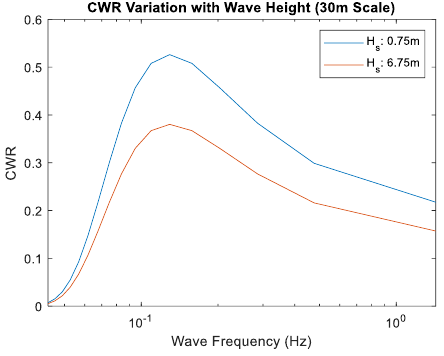
Figure 14: Example of CWR dependency on wave